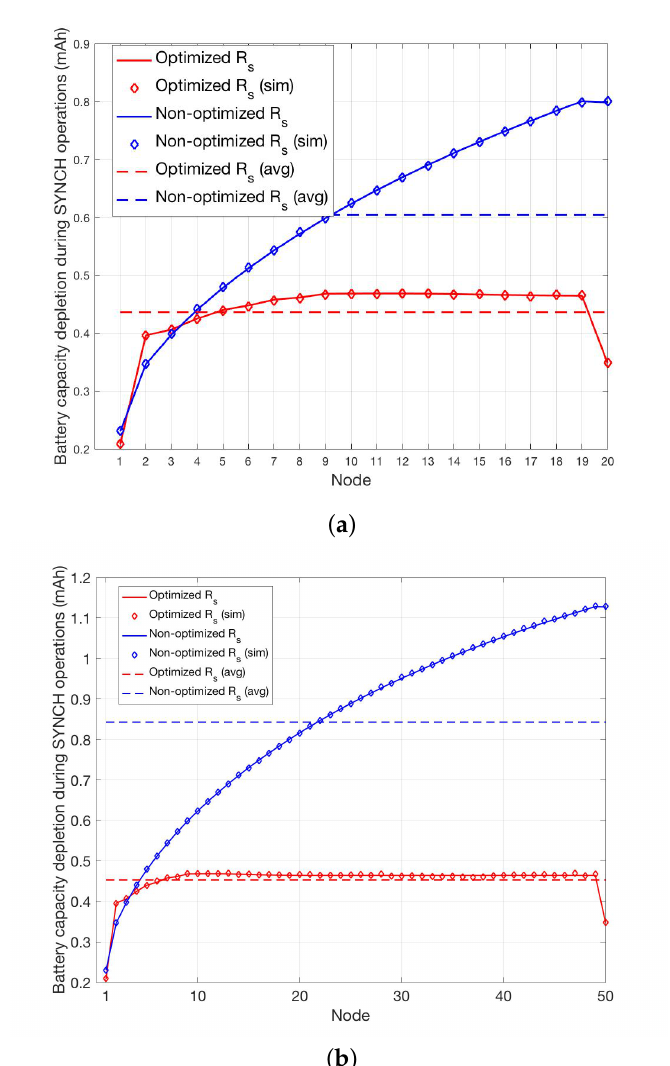
Figure 9. Per-node and average battery capacity depletion during SYNCH operations for the optimized and non-optimized schemes for N = 20 ( a ) and N = 50 ( b ).